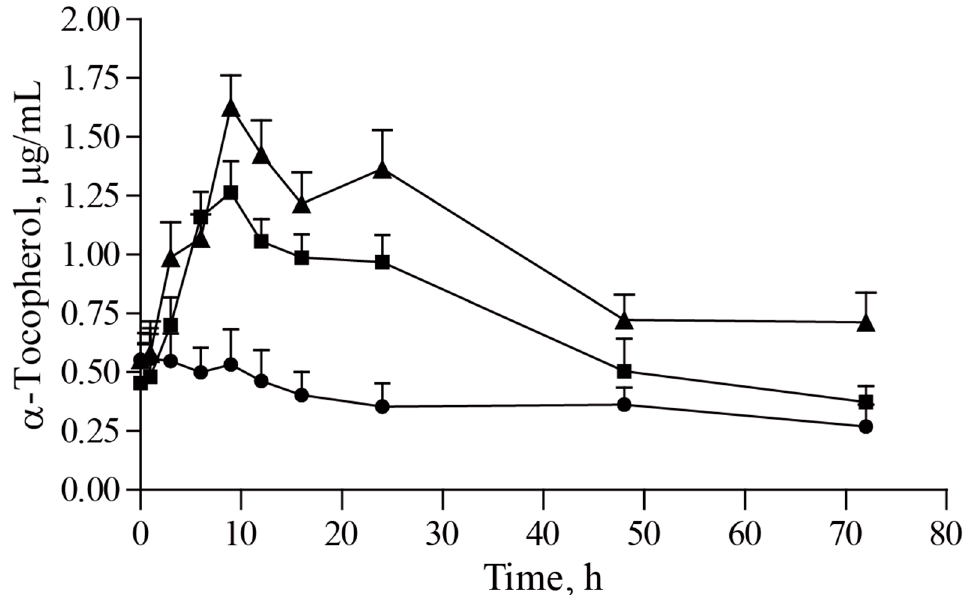
Figure 2. The plasma concentration of 25-hydroxyvitamin D 3 versus time. The concentration of 25- hydroxyvitamin D 3 in plasma from 0 to 72 h after oral placebo ( ● ), non-microencapsulated vitamin supplement ( ▪ ), and microencapsulated vitamin supplement ( ▲ ), respectively. Error bars repre- sent standard deviations.